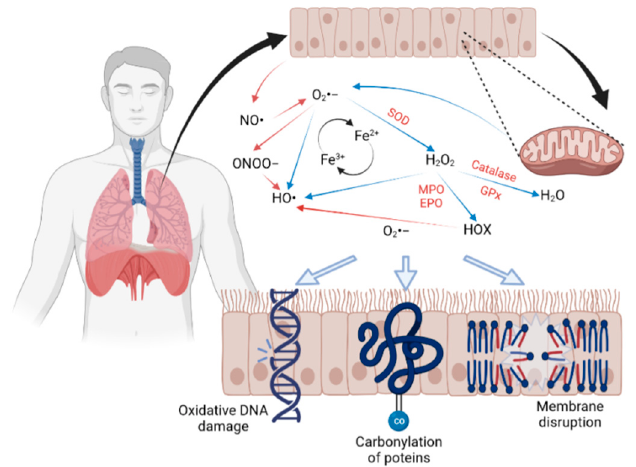
Figure 2. Air contaminants enter the respiratory tract. Once in contact with the epithelium, they increase the reactive oxygen and nitrogen species, which initiate a cascade of redox reactions that ultimately damage lipids, proteins, and DNA.